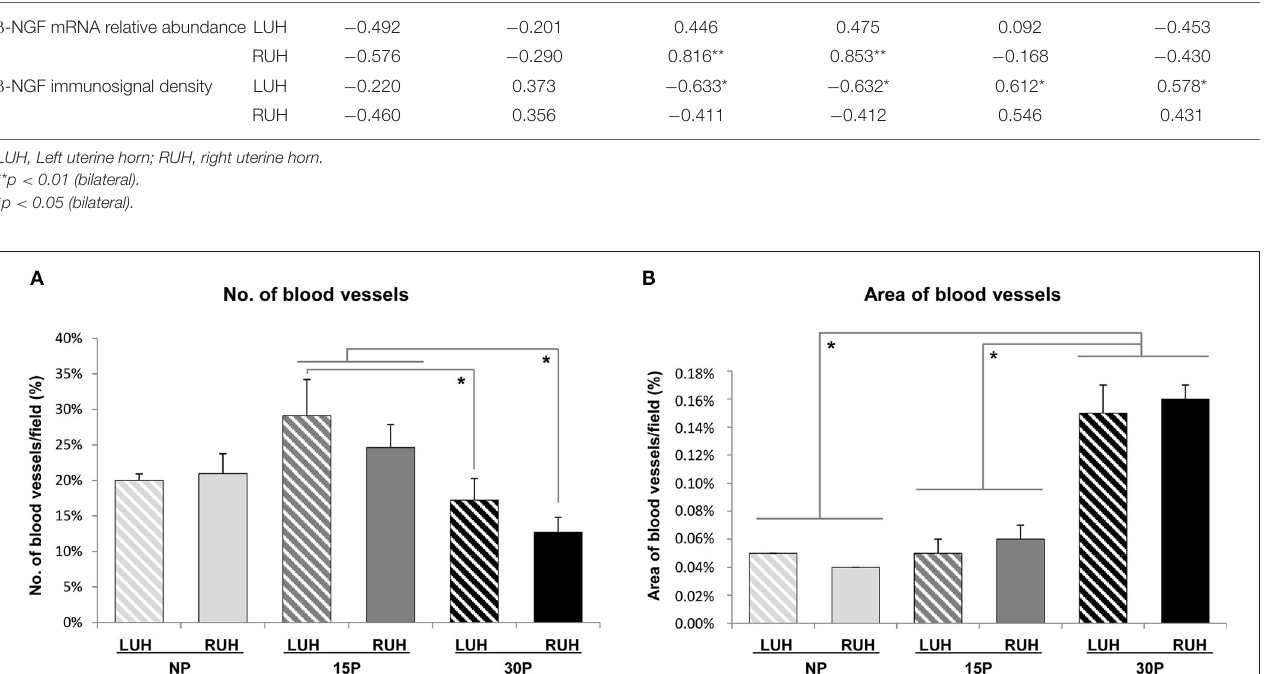
TABLE 4 | Pearson correlation coefficient between β -NGF and VEGFA, blood vessel area and number for left and right uterine horns. VEGFA mRNA relative abundance Area of blood vessels Number of blood vessels LUH RUH LUH RUH LUH RUH